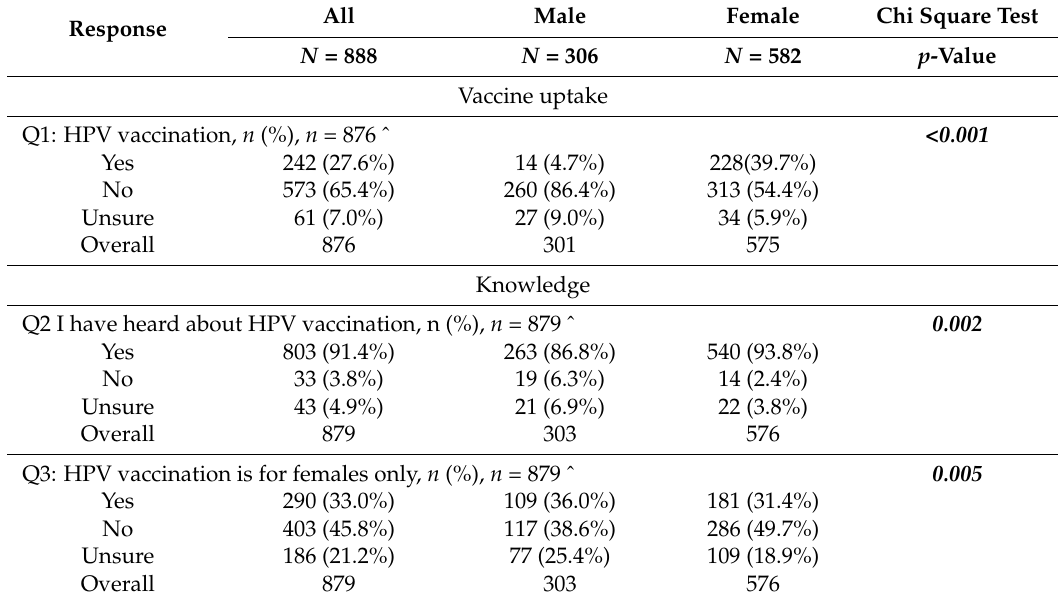
Table 1. The prevalence of HPV vaccination and HPV-related knowledge by